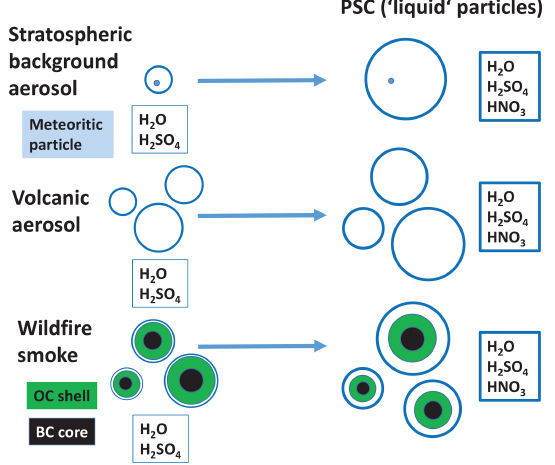
Figure 2. Formation of PSC particles (STS droplets) for three dif- ferent aerosol scenarios (clean background, volcanic aerosol, wild- fire smoke). Three aerosol particles symbolize a significant increase in aerosol particle number concentration, which leads to an in- creased STS droplet number concentration and, on average, smaller STS droplets (compared to background conditions). Insoluble mete- oritic particles (small dots, background aerosol) may be immersed within the background sulfate and STS droplets. Smoke particles are shown as BC core–OC shell structure with H 2 0 / H 2 SO 4 coat- ing (white sphere). Through HNO 3 uptake, all STS droplets grow to large sizes (see text for more